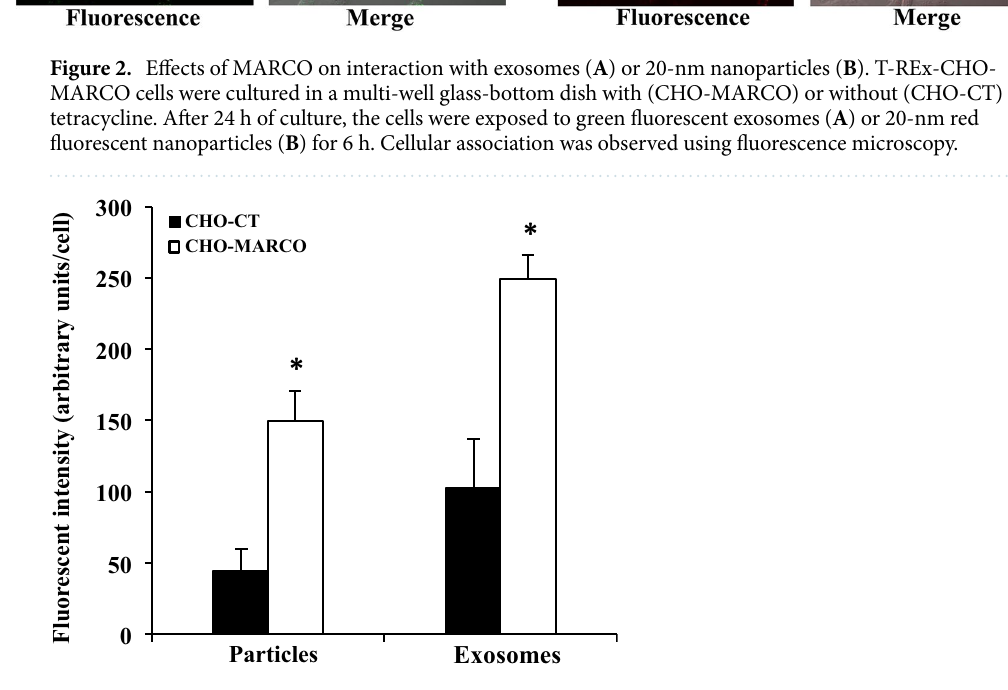
Figure 3. Quantification analyses of the association of exosomes or 20-nm nanoparticles with CHO-CT and CHO-MARCO cells. T-REx-CHO-MARCO cells were cultured in a 96-well plate with (CHO-MARCO) or without (CHO-CT) tetracycline. After 24 h of culture, the cells were treated with red fluorescent exosomes or 20-nm red fluorescent nanoparticles for 6 h. After incubation, the cells were washed twice with HBSS and fixed with 4% paraformaldehyde, followed by staining with DAPI and phalloidin. The associated fluorescent amounts were analyzed using an IN Cell Analyzer. Data are presented as means ± SEM (n=3). *, Significantly different from CHO-CT